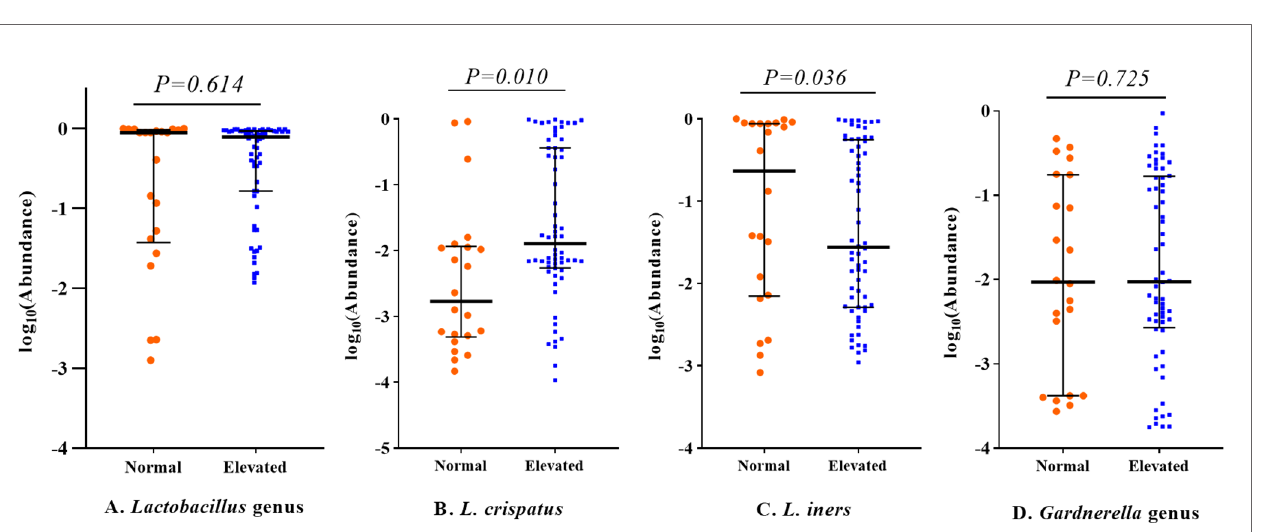
FIGURE 2 | Relative abundance of Lactobacillus and Gardnerella genera among PCOS patients with different testosterone status. All P values were adjusted for sequencing batch, vaginitis status and condom usage during sexual activity using linear regression models. The middle lines represent the median, and the error bars represent the range interquartile. (A) Lactobacillus genus ; (B) Lactobacillus crispatus ; (C) Lactobacillus iners ; (D) Gardnerella genus